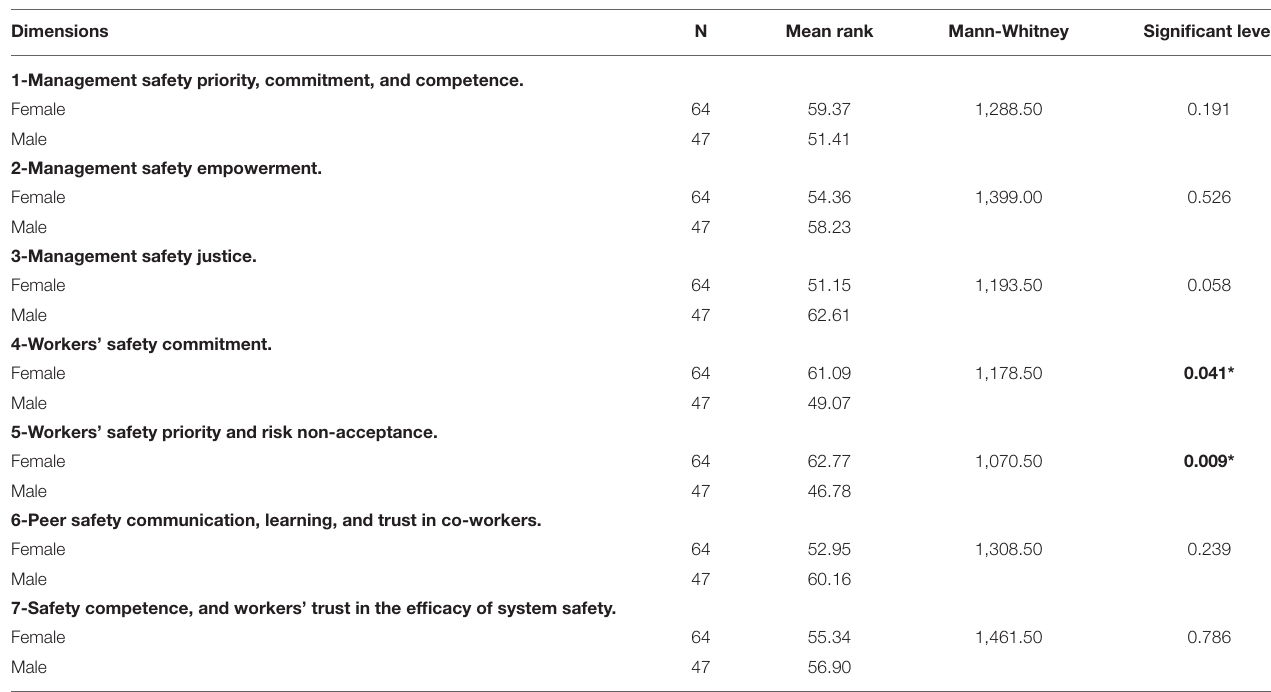
TABLE 5 | Gender differences among workers regarding safety climate perception. Dimensions N Mean